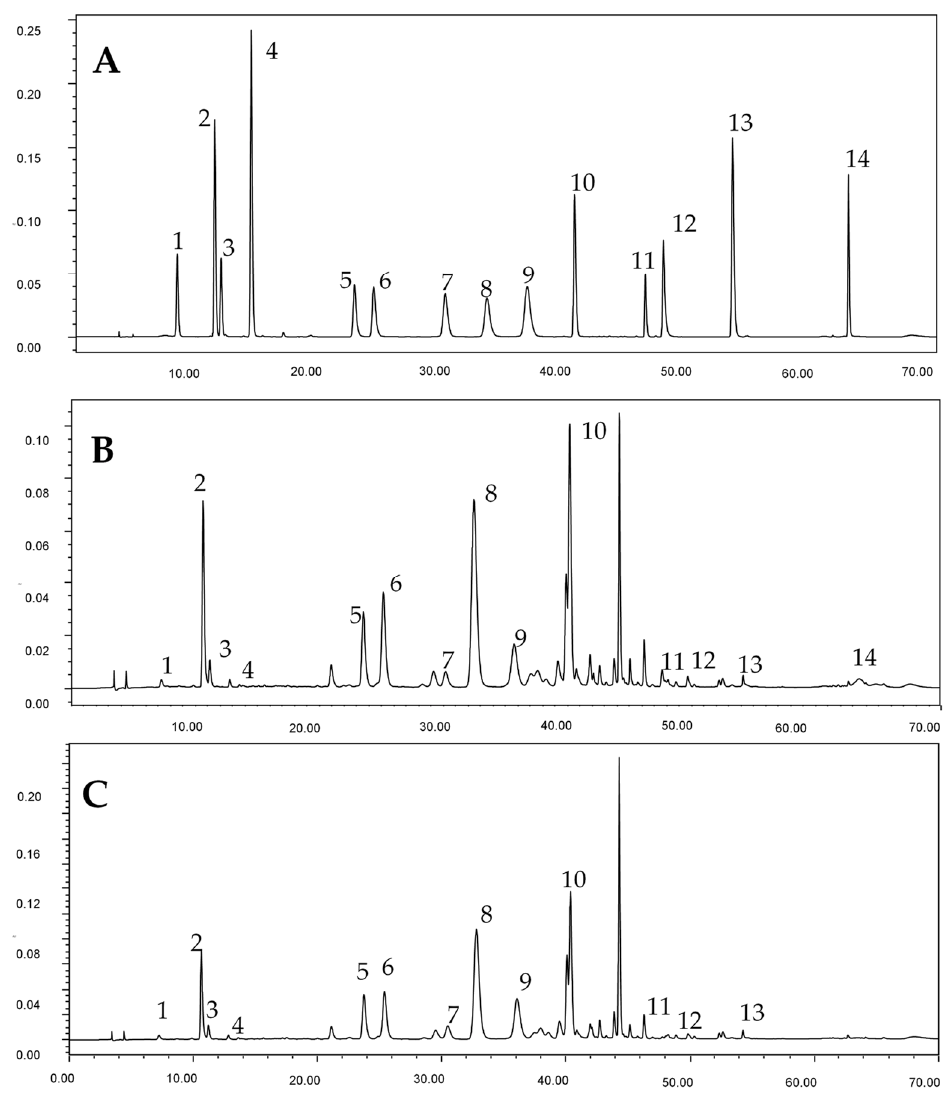
Figure 1. Chromatography of phenolic compounds of ( A ) standards, ( B ) ‘DJ2 ′ sample and ( C ) ‘TJ4 ′ sample. Peak 1, 2, 3, 4, 5, 6, 7, 8, 9, 10, 11, 12, 13 and 14 represent 3- O -caffeoylquinic acid, 5- O -caffeoylquinic acid, 4- O -caffeoylquinic acid, caffeic acid, hyperoside, luteoloside, 3,4-di- O - caffeoylquinic acid, 3,5-di- O -caffeoylquinic acid, apigenin-7- O -glucoside, 4,5-di- O -caffeoylquinic acid, linarin, luteolin, apigenin and acacetin, respectively.